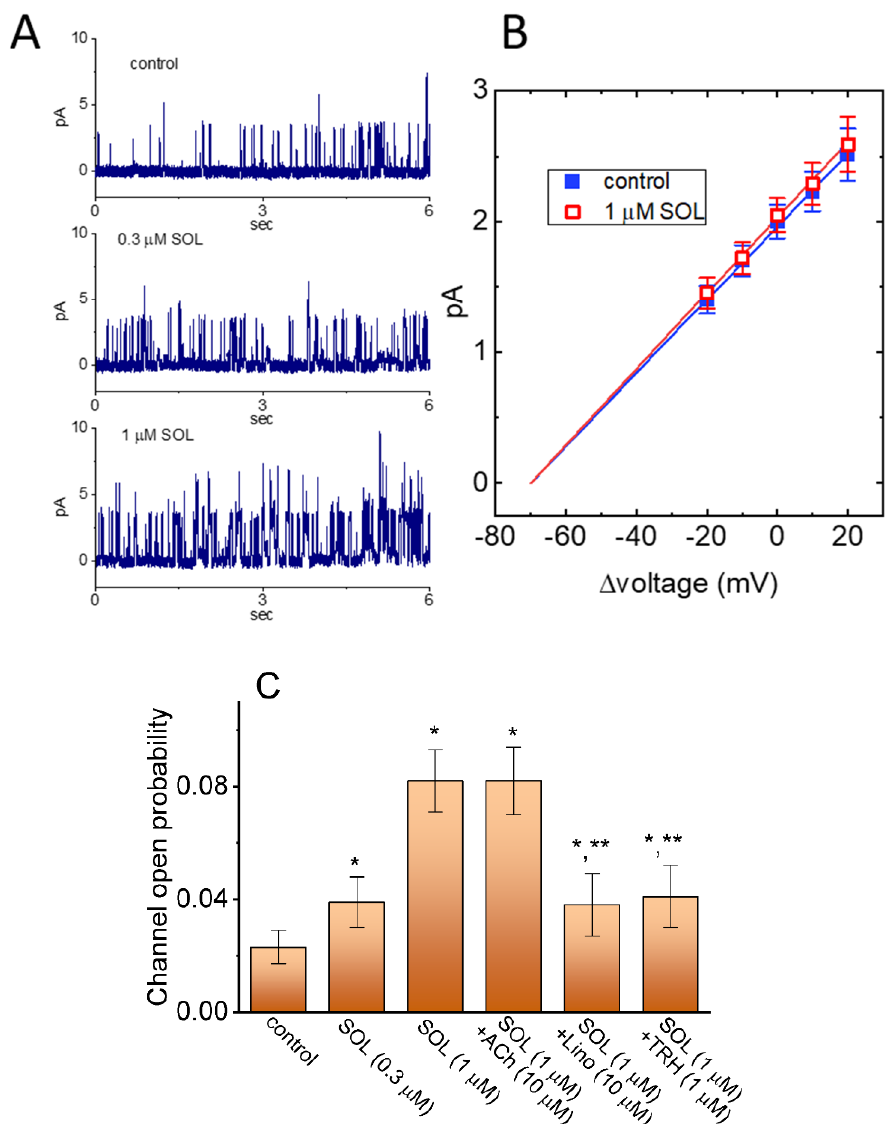
Figure 7. Stimulatory effect of SOL on the activity of M−type K + (K M ) channels in recorded GH 3 cells. In this set of cell−attached current recordings, we bathed cells in high−K + , Ca 2+ −free solution, while the recording electrode was filled up with low−K + (5.4 mM) solution. ( A ) Representative single K M −channel activity obtained in the control period (upper) and during cell exposure to 0.3 μM SOL (middle) or 1 μM SOL (lower). The examined cells were maintained at +20 mV relative to the bath, and the upward deflection indicates the opening event of the channel. ( B ) Averaged I-V relation- ships of single-channel K M currents between the absence ( ■ ) and presence ( □ ) of 1 μM SOL (mean ± SEM; n = 8 for each point). Notably, no appreciable difference in single−channel conductance of K M channels is depicted in the presence of 1 μM SOL. ( C ) Summary bar graph showing effect of SOL, SOL plus acetylcholine (ACh), SOL plus linopirdine (Lino), or SOL plus thyrotropin releasing hor- mone (TRH) on the probabilities of K M -channel openings (mean ± SEM; n = 7 for each bar). Channel activity was measured at the level of +20 mV relative to the bath. Data analysis was performed by ANOVA−1 ( P < 0.05). * Significantly different from control ( P < 0.05) and ** significantly different from SOL (1 μM) alone group ( P < 0.05).